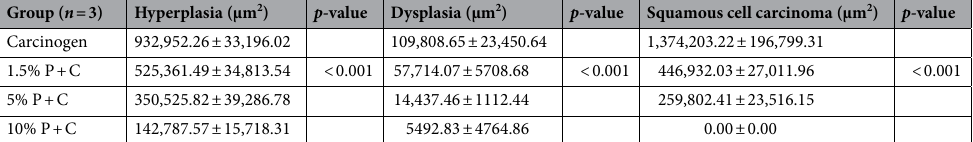
Table 3. Effect of pre and concurrent treatment of PBPs on microscopic hamster buccal pouch tumor multiplicity and area. Represented as Mean ± standard deviation, ANOVA test applied. The area of each proliferative lesion assigned by pathologists were counted in each tile scan (50 microns apart). The areas of lesions were counted by using Image J software in every tile scan for all animals and expressed as the average area of each type of lesion per hamster.